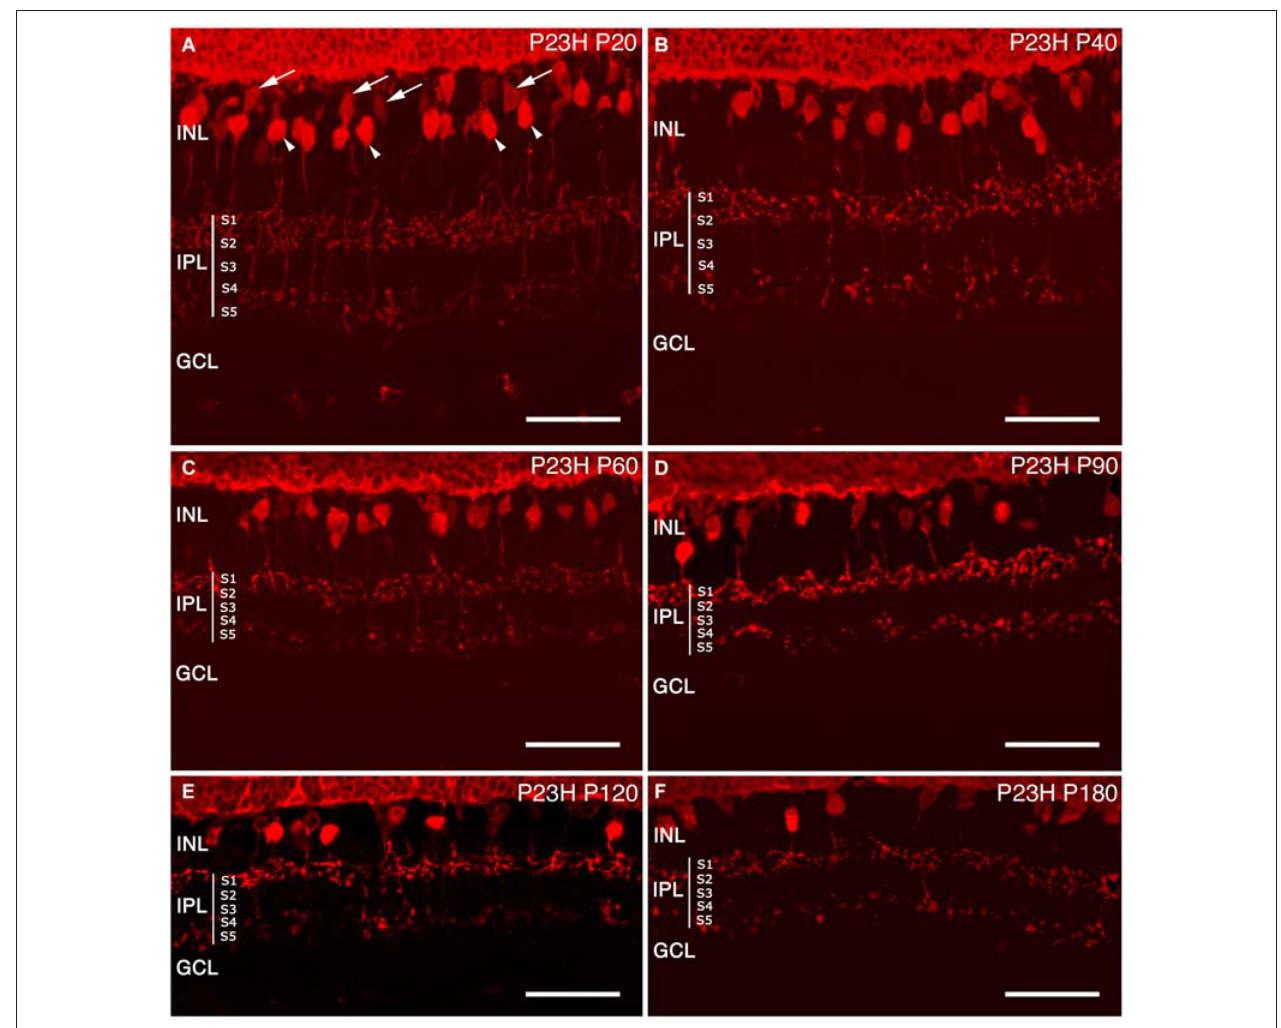
process, cone bipolar cells show changes from P60 onwards, with profuse axonal loss at the IPL level. INL: inner nuclear layer; IPL: inner plexiform layer; S1: Stratum 1; S2: Stratum 2; S3: Stratum 3; S4: Stratum 4; S5: Stratum 5; GCL: ganglion cell layer. Scale bar: 40 µ